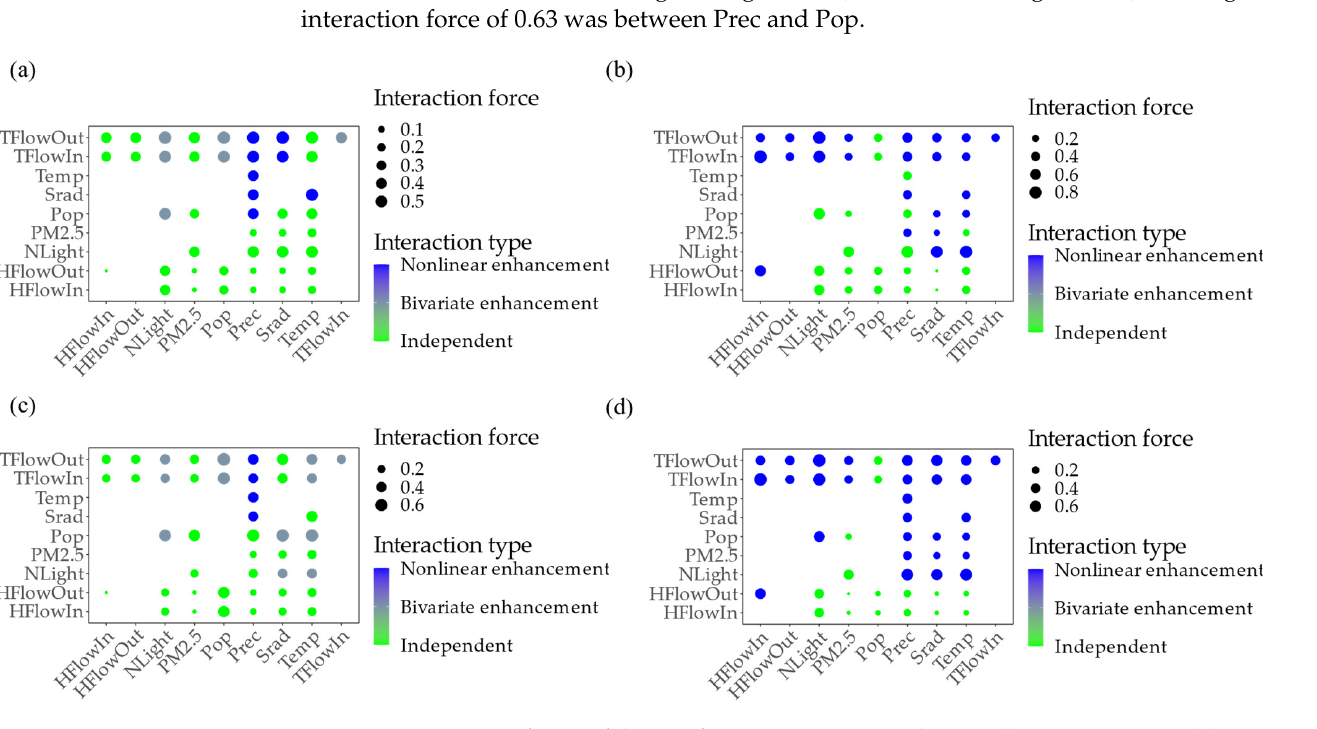
Figure 8. Interactions forces of driving factors to vegetation change. ( a ) NDVI increase; ( b ) NDVI decrease; ( c ) EVI increase; and ( d ) EVI decrease; ( c ) EVI increase; and ( d ) EVI decrease.